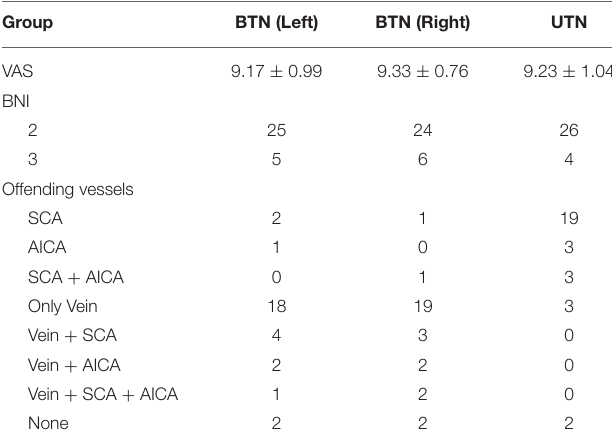
TABLE 2 | Clinical characteristics of the